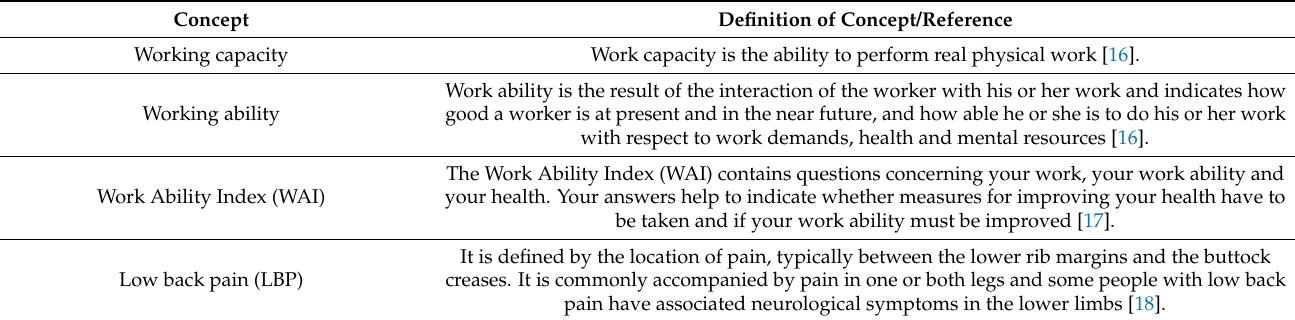
Table 1. Definitions of